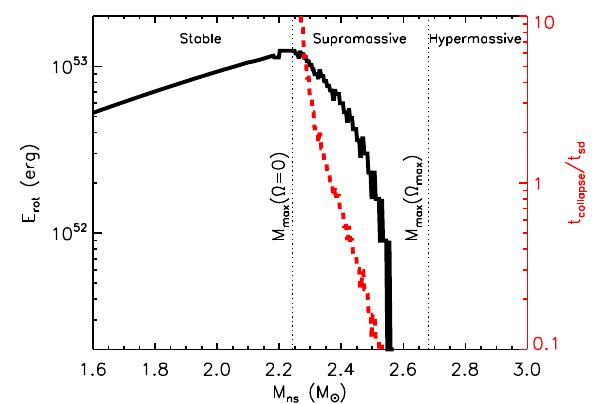
Fig.8 MaximumextractablerotationalenergyfromthemagnetarremnantofaNS–NSmergerasafunction of its gravitational mass M ns ( black line , left axis). Below the maximum mass of a non-rotating NS of M max (Ω = 0 ) , this is just the rotational energy at the mass-shedding limit. For M ns (cid:3) M max (Ω = 0 ) , the extractablerotationalenergyisthedifferencebetweenthemass-sheddinglimitattherotationalenergyatthe point of collapse into a black hole. Also show with a red dashed line is the time to spin-down via magnetic dipole to the point of collapse, in units of the characteristic spin-down time t sd (Eq. 33). The remnant mass of a merger consisting of two NSs of mass ≈ 1 . 3 − 1 . 4 M (cid:4) is typically ≈ 2 . 3 − 2 . 5 M (cid:4) , after accounting for neutrino losses and mass ejection (Ruffert et al. 1997; Belczynski et al. 2008; Kaplan et al. 2014). The structure of the solid-body rotating NS is calculated using the rns code (Stergioulas and Friedman 1995) assuming a parameterized piecewise polytropic EOS with an adiabatic index (cid:17) = 3 above the break density of ρ 1 = 10 14 . 7 g cm − 3 at a pressure of P 1 = 3 . 2 × 10 34 dyn cm − 2 (Margalit et al. 2015). The chosen EOS results in a 1 . 4 M (cid:4) NS radius of 10.6 Km and maximum non-rotating mass of M max (Ω = 0 ) ≈ 2 . 24 M (cid:4) . This figure is modified from a related figure in Metzger et al.